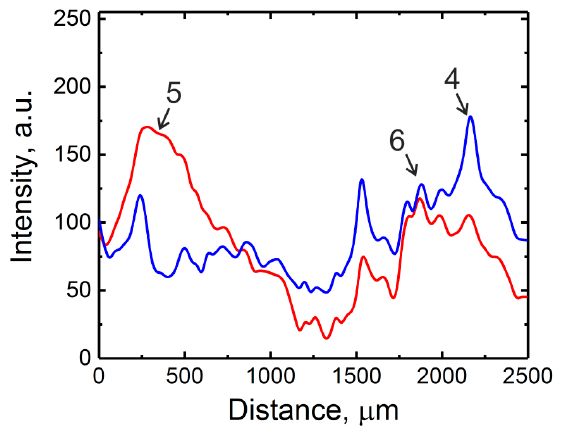
Figure 3. Contrast intensity profiles of lines (showed as the green lines in Figure 2b,d) across the speckle contrast images before and after the correction procedure. The red line corresponds to the contrast intensity profile of the speckle contrast image before the correction procedure. The blue line corresponds to the contrast intensity profile of the speckle contrast image after correction procedure. Points 4, 5, and 6 correspond to artery, sagittal sinus, and vein (showed as the same points in Figure 2b,d), respectively.